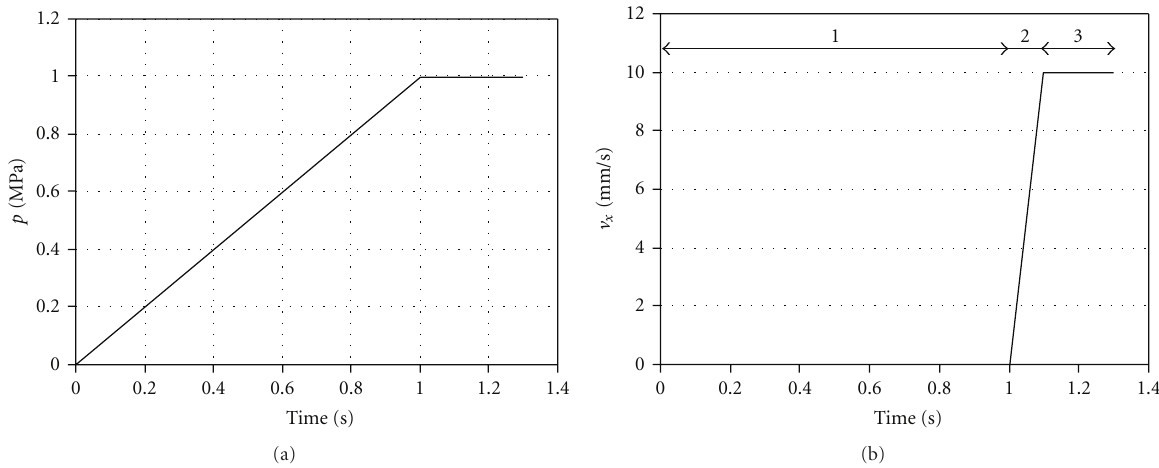
Figure 3: Time curves to control the pressure load (a) and the horizontal motion (b) of the rubber segment. 1: indentation; 2: acceleration; 3: sliding with constant